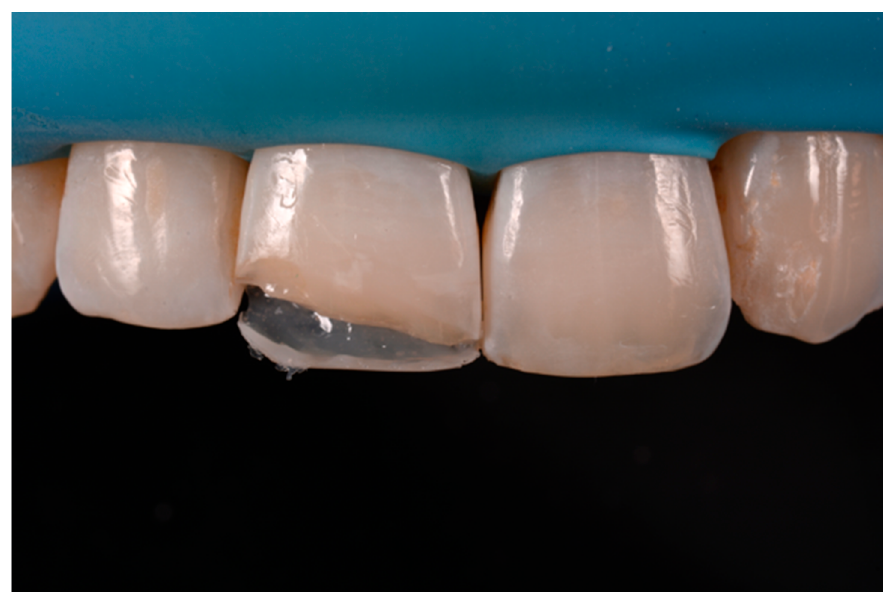
Figure 50. Palatal translucent and incisal opaque material molded using a silicone index.